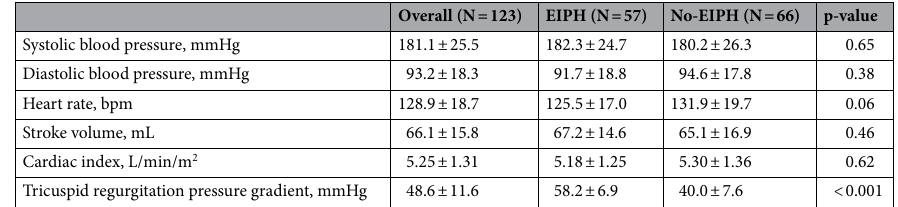
Table 2. Hemodynamics at peak workload. EIPH exercise-induced pulmonary